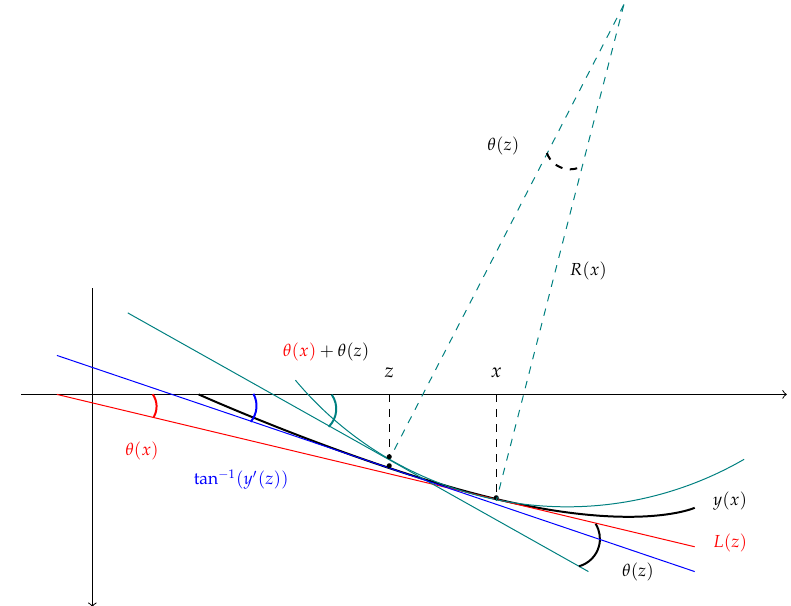
Figure 4. Tangent lines to the elastic curve and the osculating